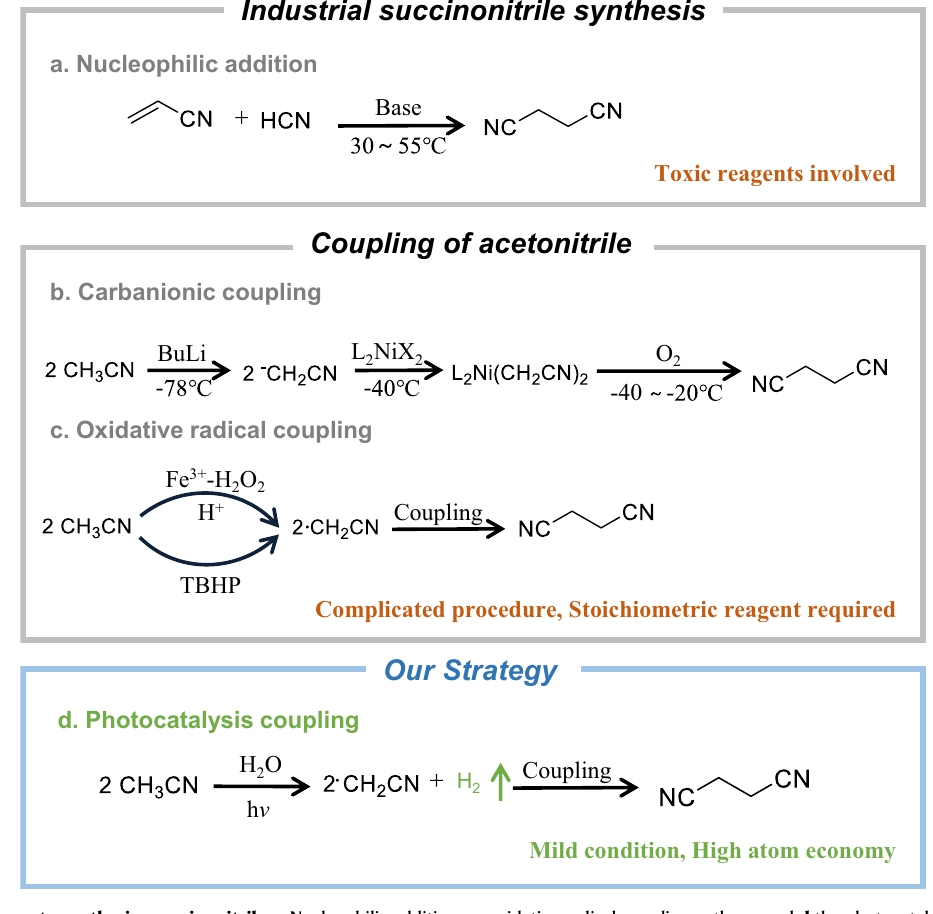
oxidative radical coupling pathway and d the photocatalytic dehydrogenative coupling of acetonitrile proposed in this